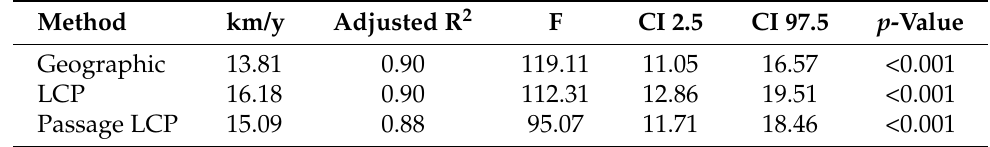
Table 1. Results of simple linear models of the R. nitidula expansion spread rate at the landscape scale based on three methods for calculating spread distance.